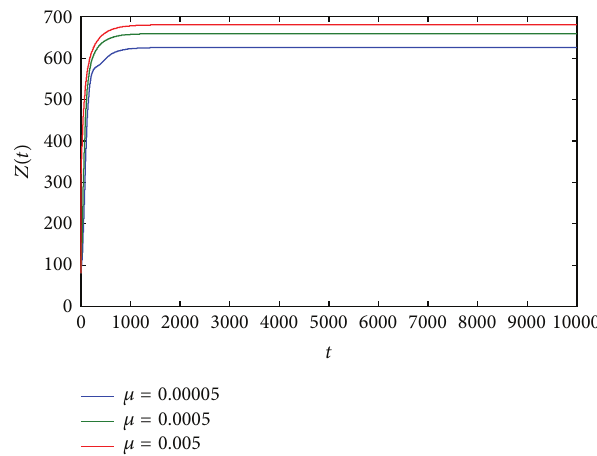
Figure 4: Size of the spreader class over time under different spreading rate 𝜇 with 𝜀 = 3 , 𝑘 1 = 0.00005 , 𝑘 2 = 0.002 , 𝑘 3 = 0.004 , = 0.0002 , 𝛽 = 0.00015 , 𝜎 = 0.0015 , 𝛼 = 0.015 , 𝜃 = 0.0001 , and 𝑘 4 𝜆 = 0.6